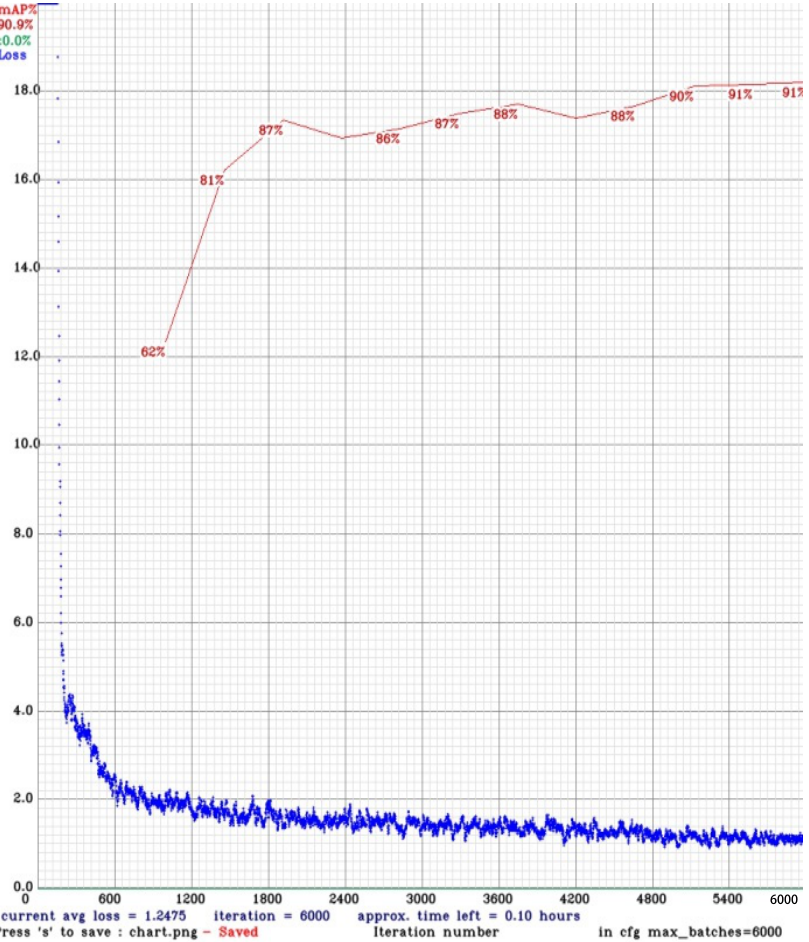
Figure 10. RTX 2080TI trained the best performing models: mAP vs. avg. loss: Model with IoU loss and new coordinates removed and IoU normalization change from 0.05 to 0.07 along with a change of loss function to linear from logistic with default hyperparameters settings at an image resolution of 512 × 512 giving mAP of 90.1 and lowest loss of 1.24. Table 5. Model 3: Scaled-YOLOv4 Optimization Configuration, and Parameter Tuning using GPU Tesla